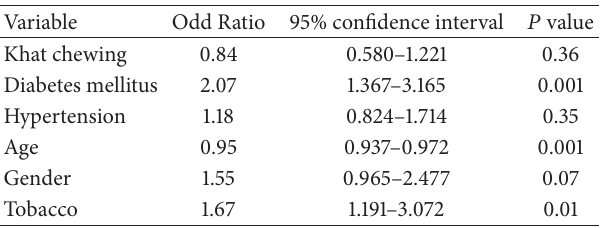
Table 2: Multivariate logistic regression analysis for predictors for the presence of significant coronary artery stenosis ∗